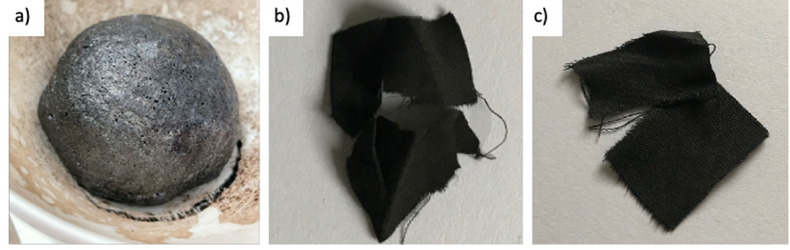
Figure 3. Snapshots of M ‐ GLY ( a ), COT/M ‐ GLY ( b ) and COT ( c ) heated at 420 °C in air.